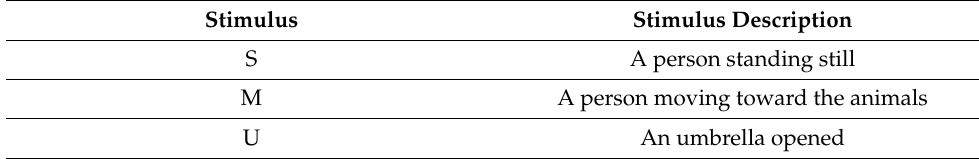
Figure 3. The stimulus of the umbrella opened inside the enclosure. Table 1. Visual stimuli presented to the